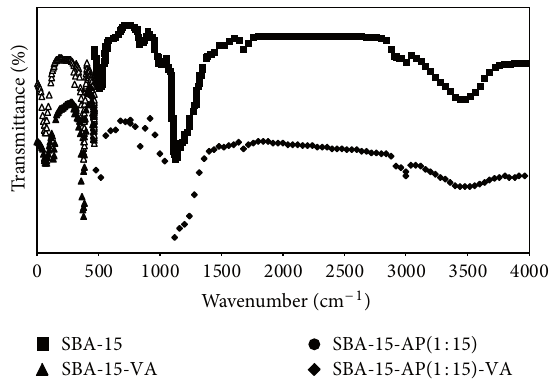
Figure 9(b) (enthalpy in terms of micromoles of valproic acid on SBA-15-AP(1 : 5) expressed in grams) for the valproic acid in solution shows an abrupt change that is characteristic of simple interaction between a single-NH group (of SBA- 15-APTES) and the adsorbent (valproic acid), but when the 2 adsorbate or adsorbent has several functional groups, such as –NH in of SBA-15, a competition is generated on the adsorbent surface, producing an initially strong enthalpic 2 peak, and then smooth curves, which is associated with the presence of six binding sites on SBA-15. On the other hand, the valproic acid site shows only one chemical bond that we associated with the interaction of the